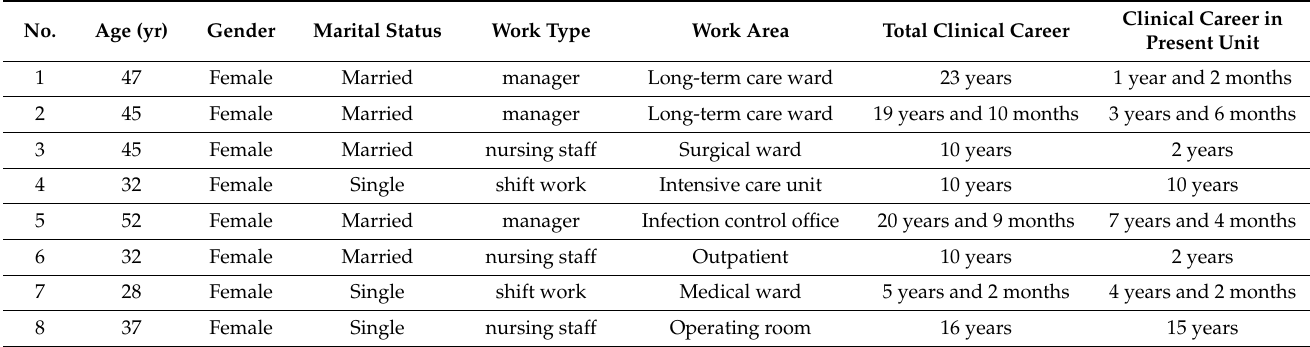
Table 1. Characteristics of Participants (N =